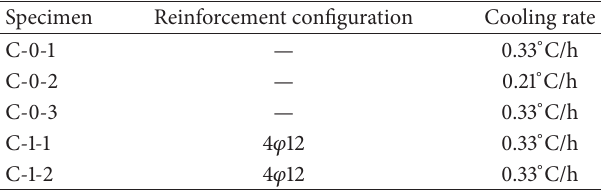
Table 2: Specimen numbers and parameters.